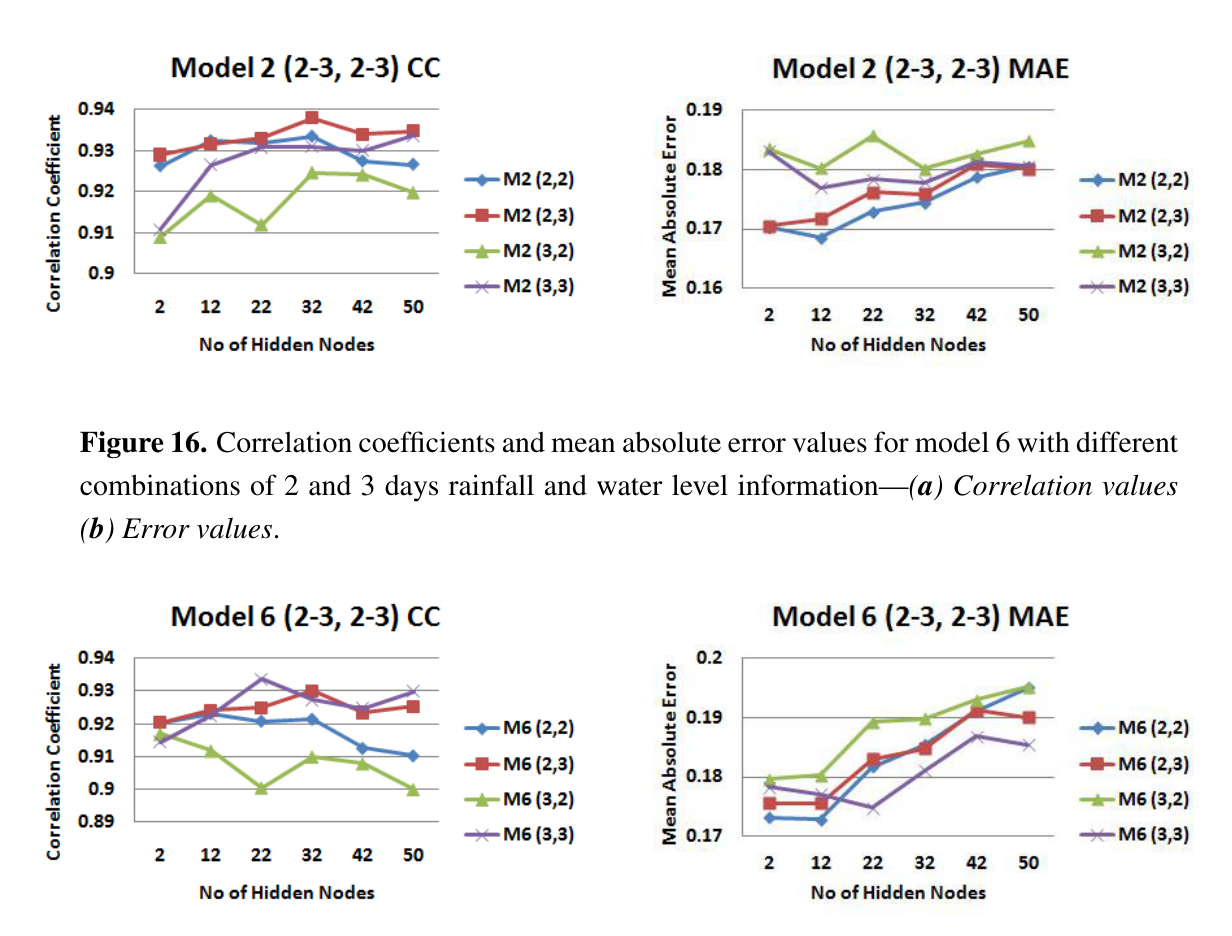
Figure 15. Correlation coefficients and mean absolute error values for model 2 with different combinations of 2 and 3 days rainfall and water level information— ( a ) Correlation values ( b ) Error values .